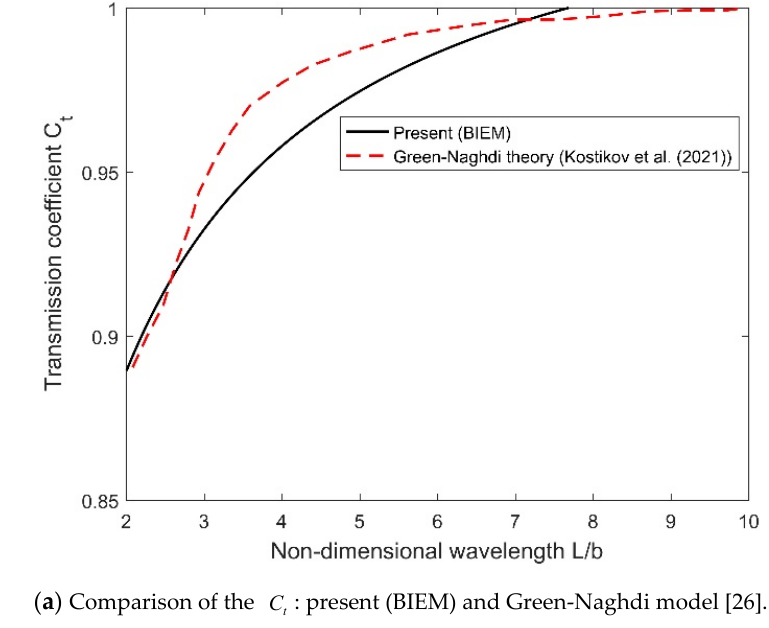
8 of 15 Figure 3. Comparison of the deflection amplitude with the model [24] and experimental data in [25]. Figure 4 shows the comparisons of